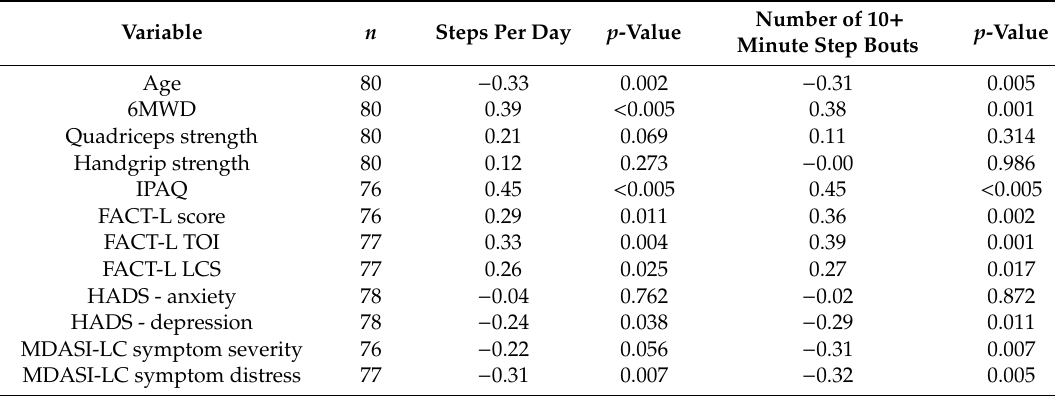
Associations between baseline objective PA, demographics, physical function and patient-reported